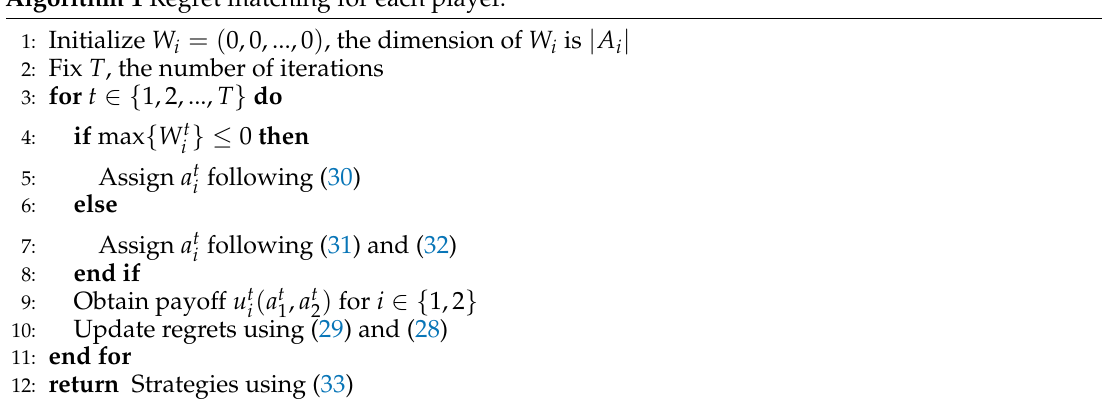
Algorithm 1 Regret matching for each